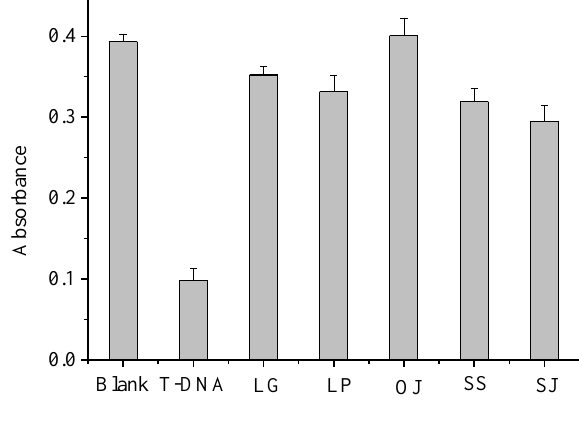
Figure 5. Absorbance value at 419 nm of the G-quadruplex DNAzyme MB colorimetric system containing probe-4 (1.0 × 10 −7 mol·L −1 ) in the presence of T-DNA (1.0 × 10 −7 mol·L −1 ) or C-DNA (1.0 × 10 −7 mol·L -1 )